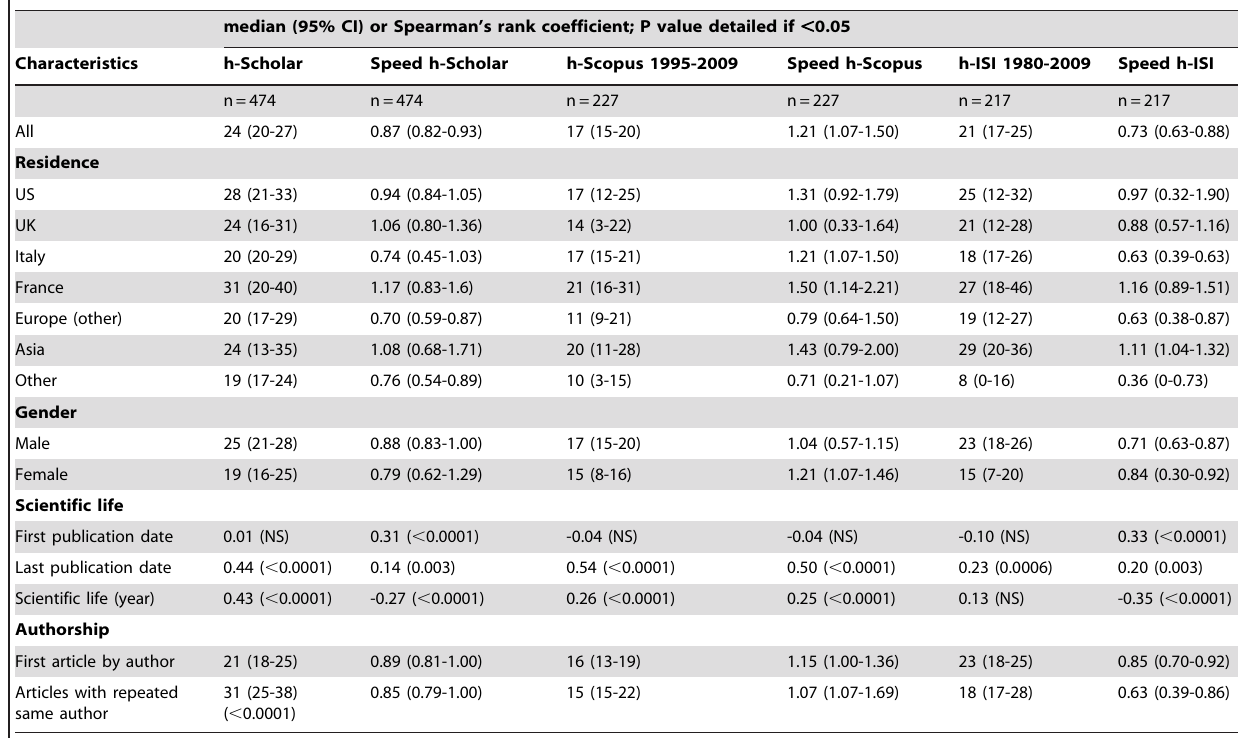
Table 3. Hirsch index according to characteristics of included first